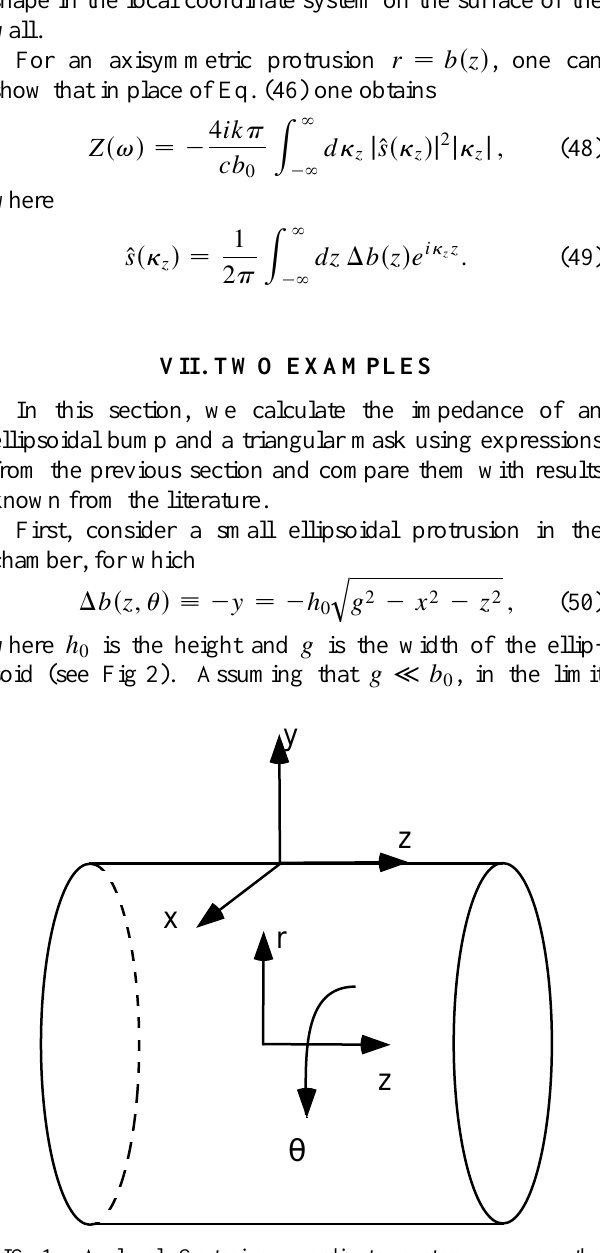
FIG. 1. A local Cartesian coordinate system (cid:120)(cid:121)(cid:122) on the surface and a cylindrical coordinate system (cid:114) u (cid:122) in the vacuum chamber of circular cross